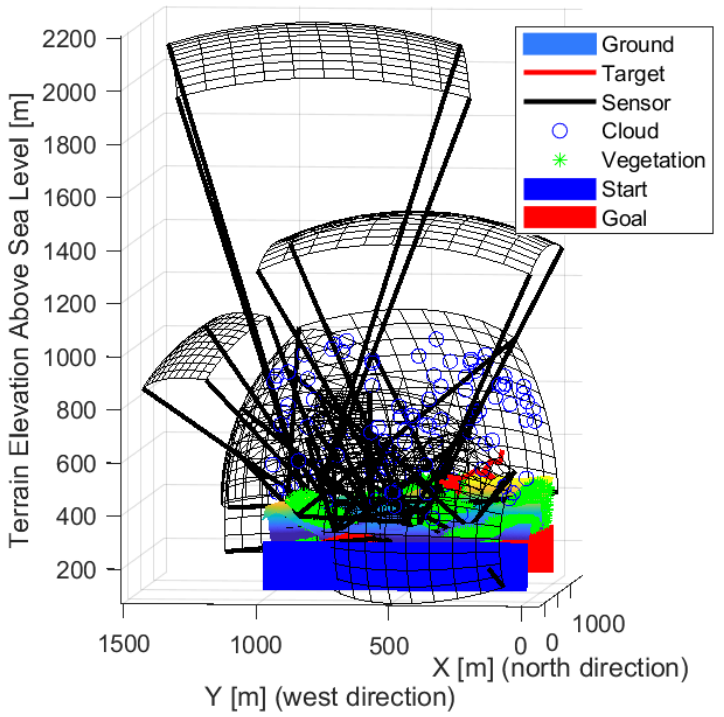
Figure 18. The solution in the case of the thirteen sensors front-wise.